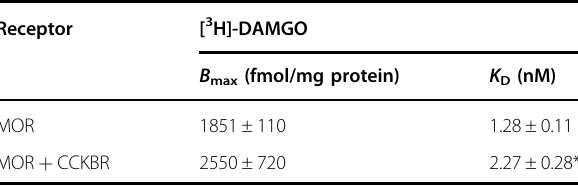
Table 1 Results of radio-ligand-binding assay of